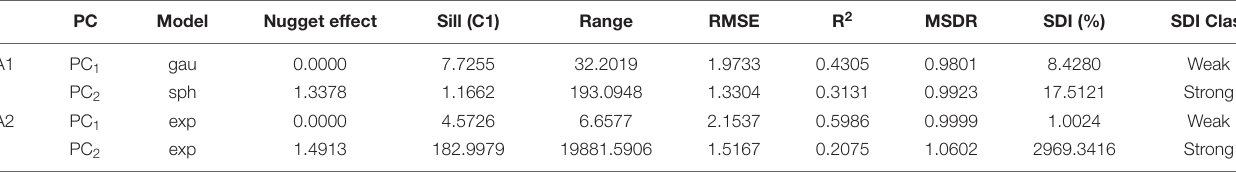
TABLE 1 | Parameters of the theoretical models adjusted to the experimental variograms of the data set at a depth of 0–20 cm, Experimental Area 1 (EA1) and 2 (EA2).